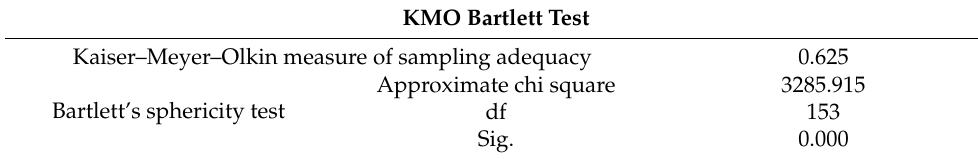
Table 2. The results of the KMO Bartlett test.